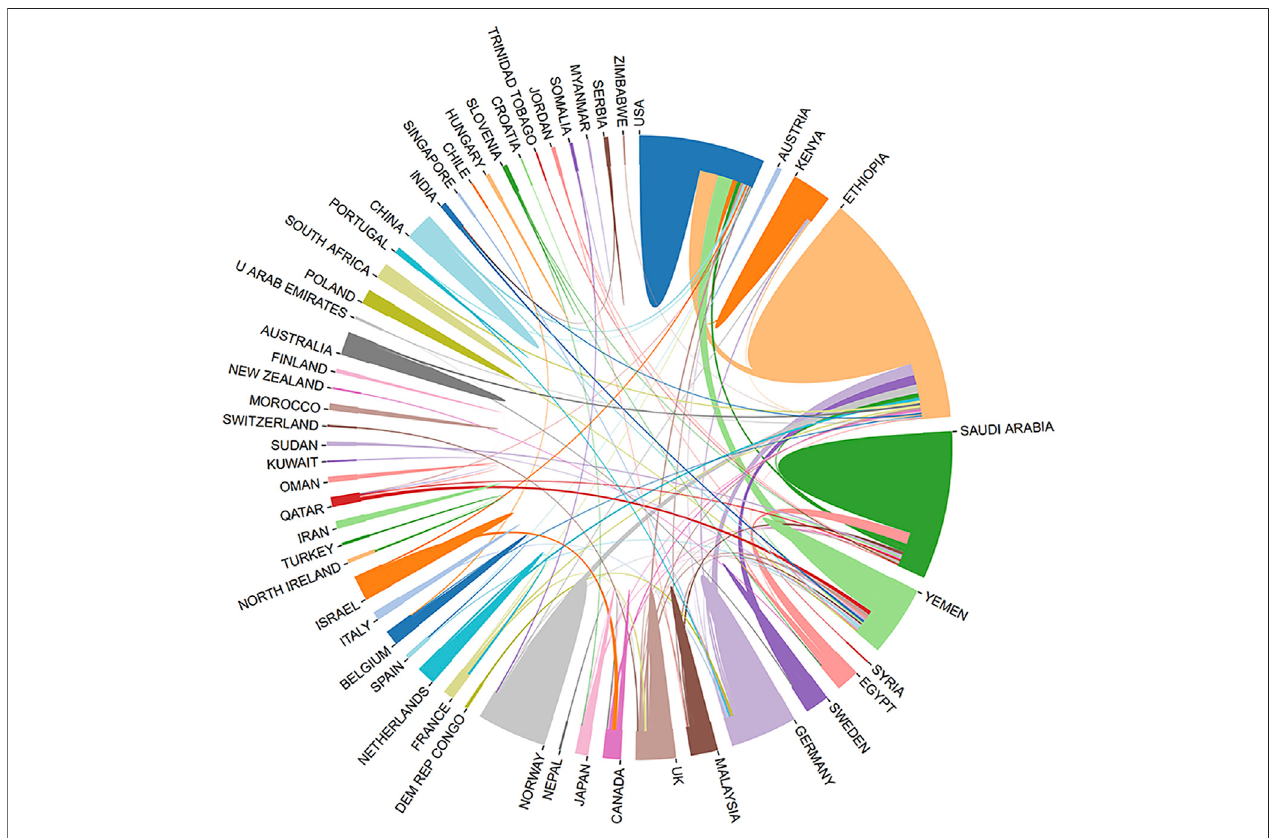
FIGURE 3 | Cooperation between contributed